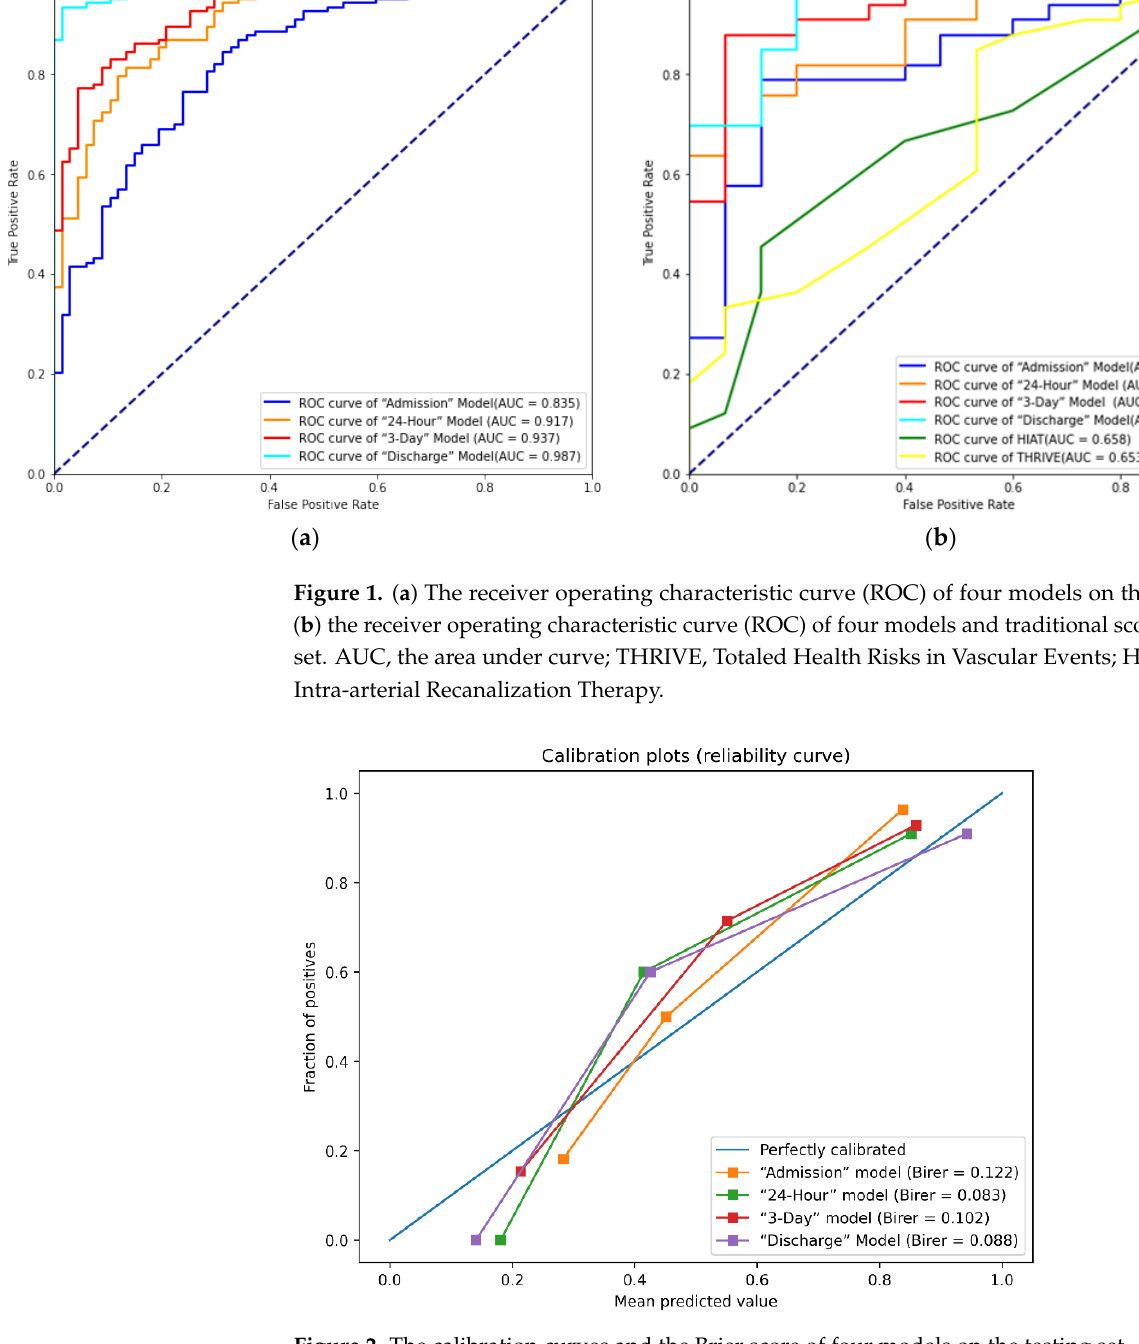
Figure 2. The calibration curves and the Brier score of four models on the testing set.